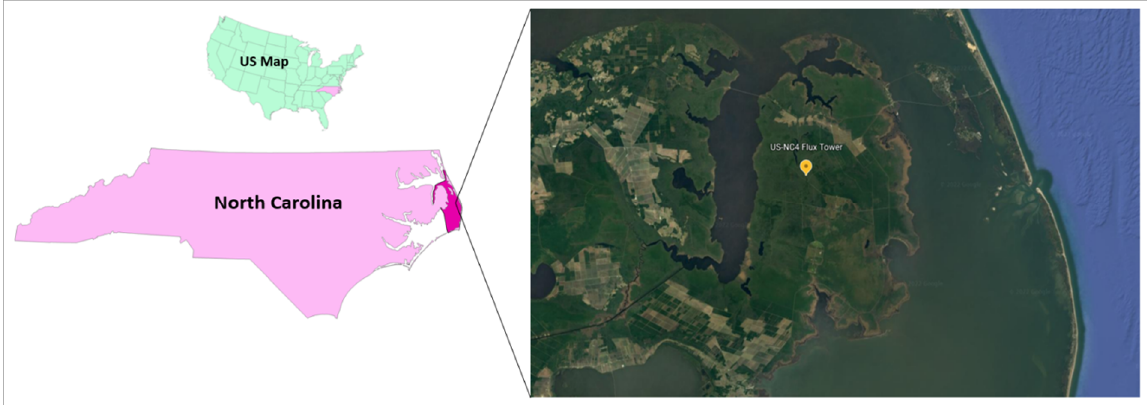
Figure 1. Location of the eddy covariance flux tower established at the Alligator River National Wildlife Refuge. (ARNWR), Dare Country, North Carlina, USA. Map taken from Google Earth version 9.166.0.1 (accessed on 25 May 2022).